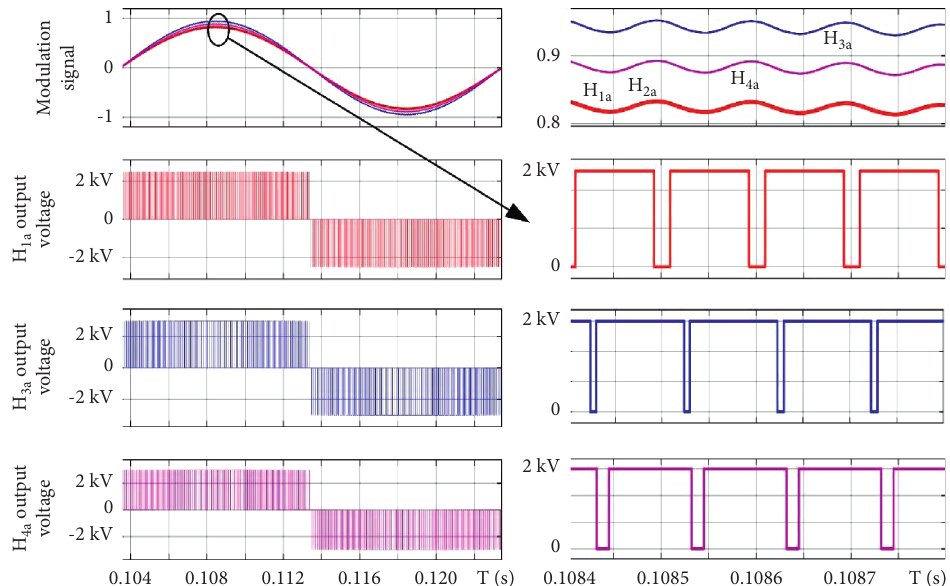
Figure 10: Modulation waves and module output voltage waveforms of different SOC values of DC unit